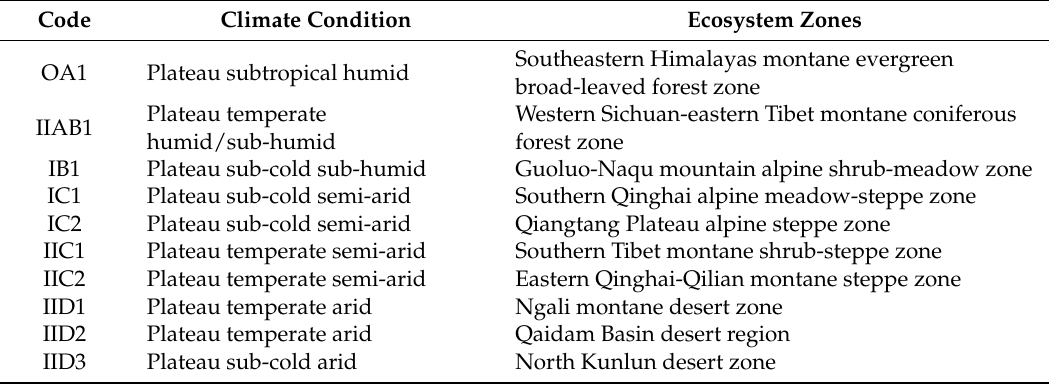
Figure 1. Vegetation types and ecosystem zones on the Tibetan Plateau (TP). Table 1. Information of the 11 ecosystem zones on the Tibetan Plateau (TP).